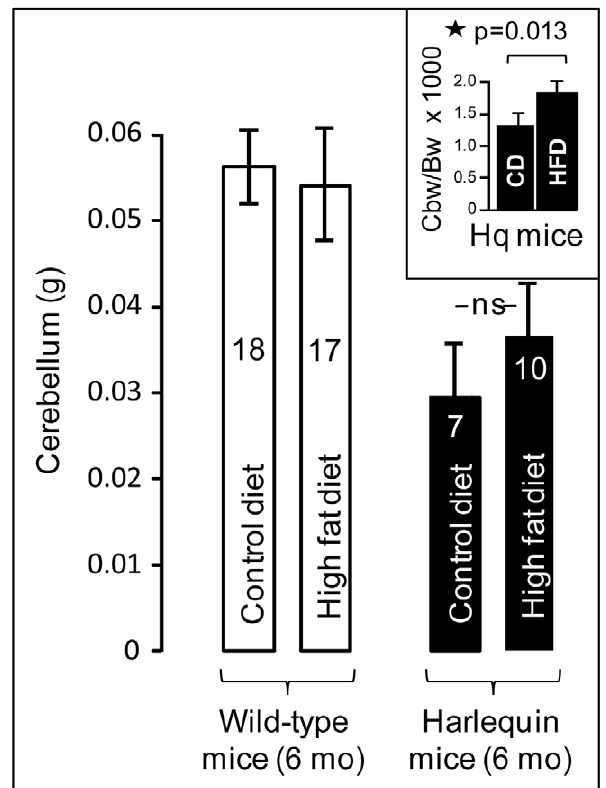
Figure 10. Weight of the dissected cerebella at 6 months of age in wild type (open bars) and Harlequin (dark bars) individuals fed the control or high fat diet. The number of animals is indicated inside each bar. The higher weight of cerebella from HFD-fed Hq animals (compared to CD-fed Hq animals) became significant when ratios of the cerebellar weight (Cbw) to the animal body weight (Bw) 6 1000 were compared (inset). ns: non-significant.